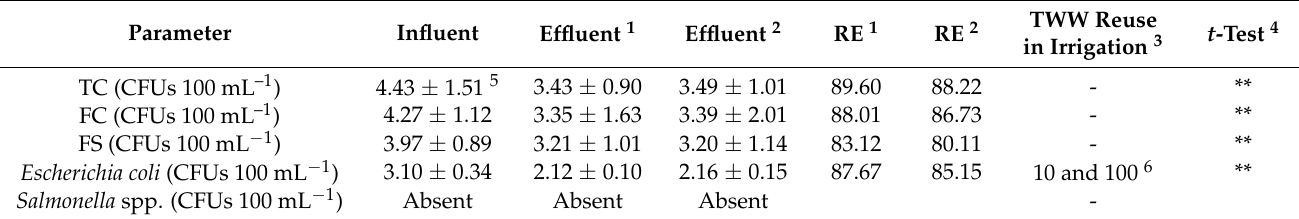
Table 3. Main microbiological composition of the treated wastewater (TWW) from inlet to outlet of the HSSFs CW. Removal efficiency (RE) from March to October 2014/2018. For each unit, five-year average values ( ± standard deviation) are shown ( n = 80). Parameter Influent